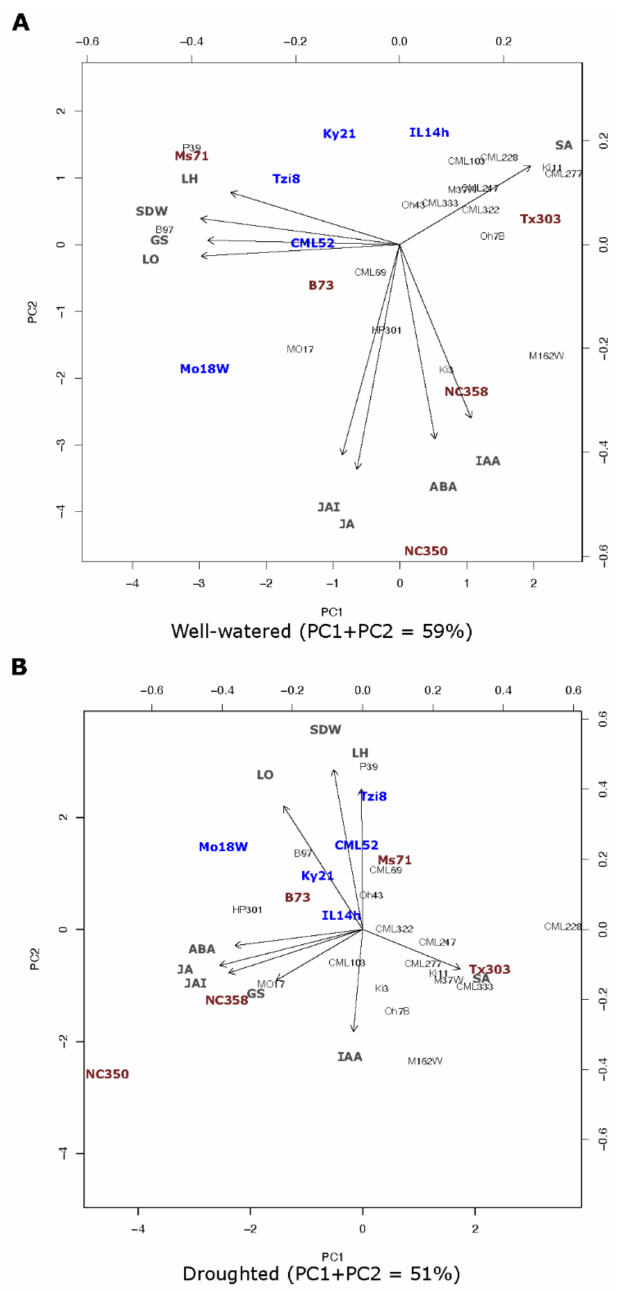
Figure 5. PCA analysis with data for shoot dry weight, Gs, Lo, Lh and sap hormonal content (ABA, IAA, SA, JA and JA-Ile) in the whole maize NAM population cultivated under well-watered conditions ( A ) or subjected to drought stress ( B